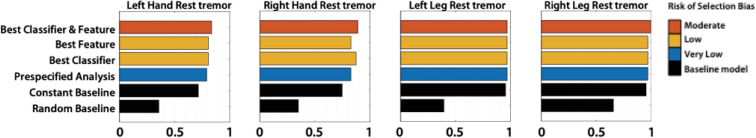
CUSSP study results of PDkit predictive performance.Item-level performance based on LOSO-CV calculations for four tremor tests conducted using the cloudUPDRS app.